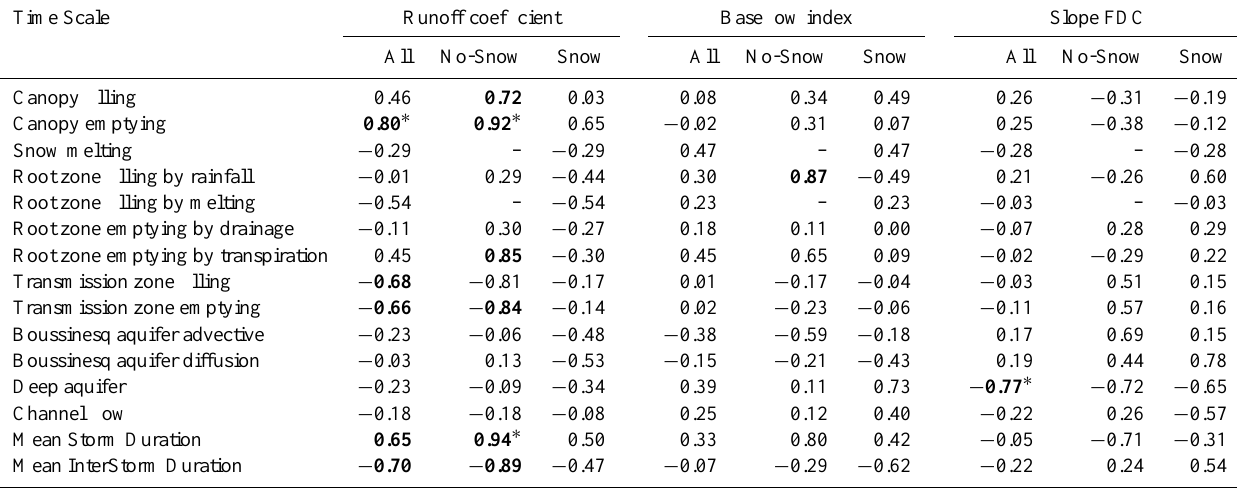
Table 5. Linear correlation coefficients between hydrologic signatures and model time scales.